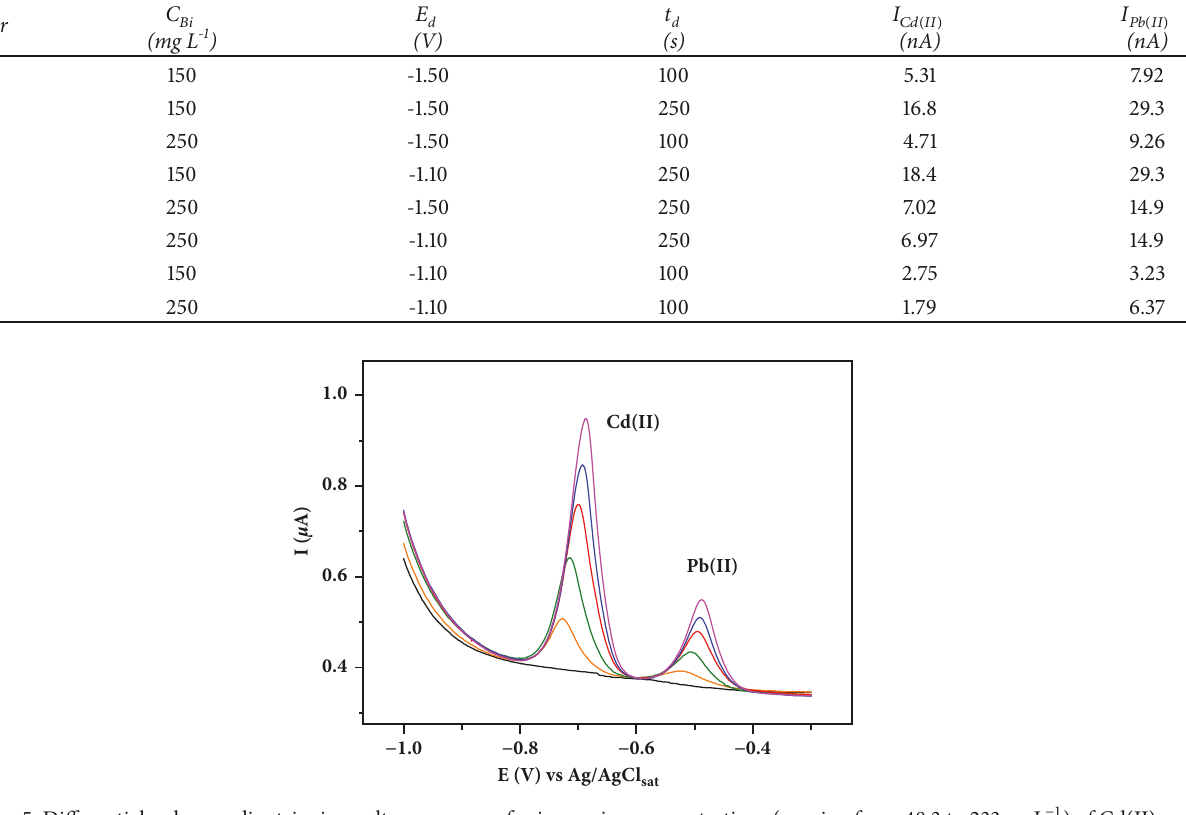
Figure 5: Differential pulse anodic stripping voltammograms for increasing concentrations (ranging from 48.3 to 233 𝜇 g L −1 ) of Cd(II) and Pb(II) in 0.10 mol L −1 acetate buffer solution (pH 4.5) as supporting electrolyte using